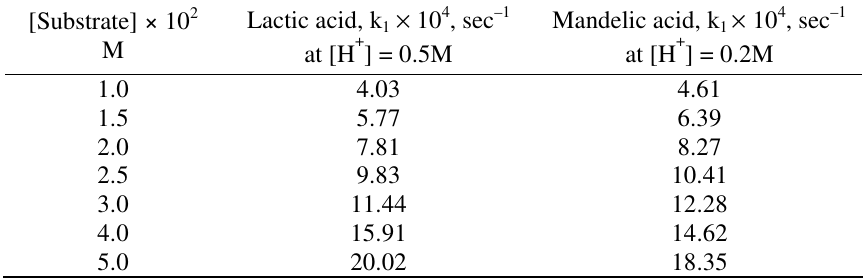
Table 1. Variation of rate with substrate